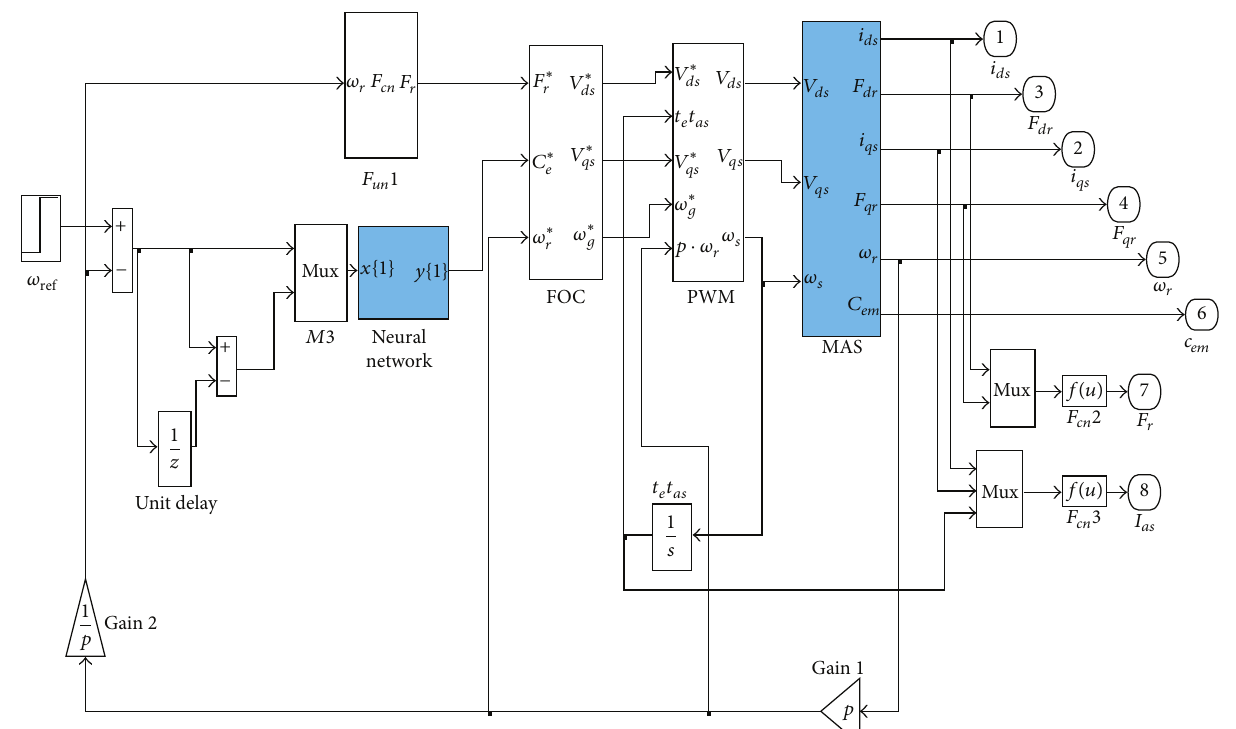
Figure 3: Block diagram in Simulink of the association vector command of the asynchronous machine and the neuronal regulator.